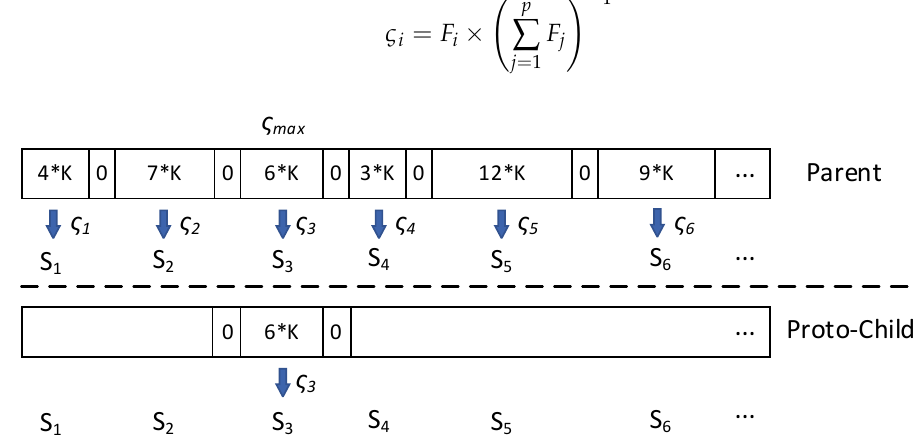
Figure 5. Selection of tasks, where perform a “select” operation on tasks in the queue.